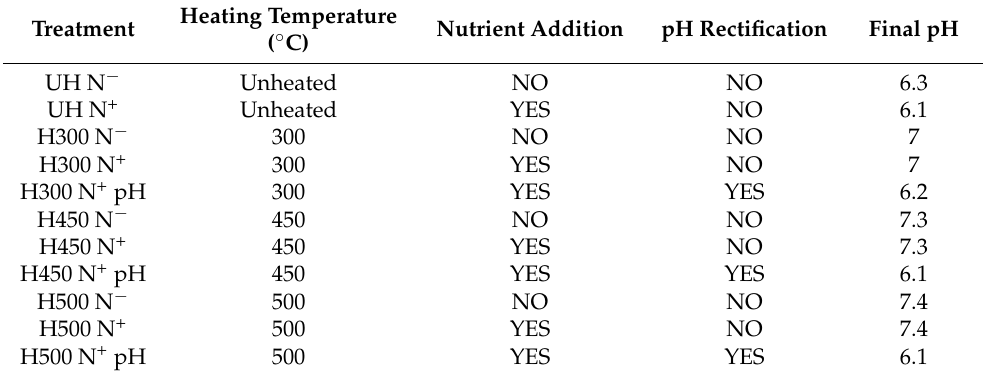
Table 1. Description of different culture media prepared with soil:water extract. Heating Temperature Nutrient Addition pH Treatment ( ◦ C)